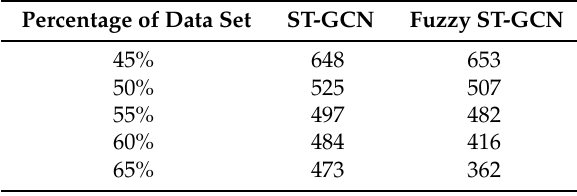
Table 3. The number of epochs.